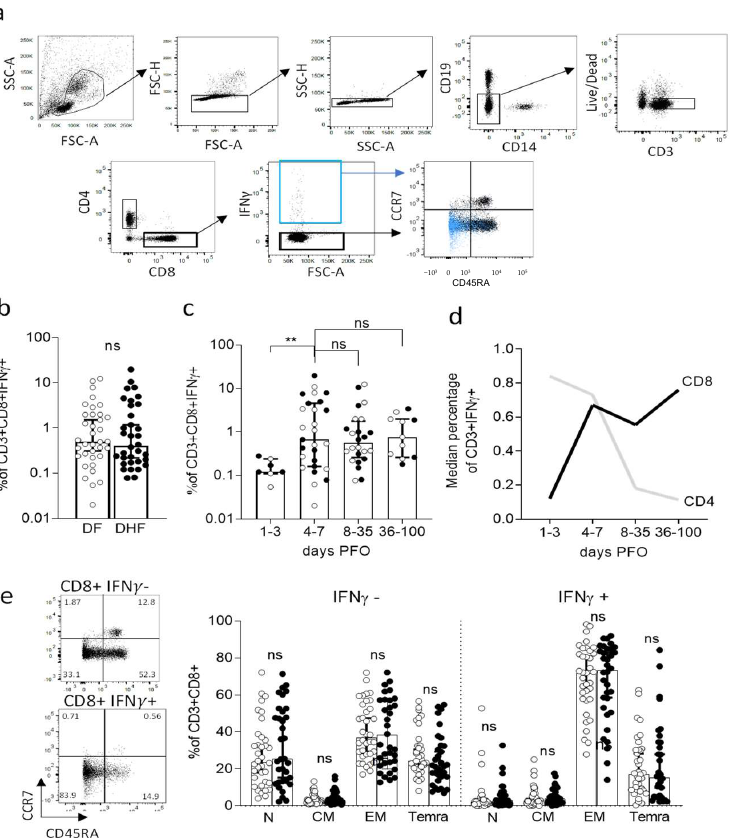
Figure 1. Flow cytometry analysis of DENV-specific CD8+ T cells in DENV hospitalized donors. ( a ) Gating strategy. ( b ) Magnitude of CD3 + CD8+ IFNγ+ T cells responses as a function of disease severity. ( c ) Magnitude of CD3 + CD8+ IFNγ+ T cells responses as a function of days post fever onset (PFO). ( d ) Median percentage of CD3 + CD8+ IFNγ+ T cells compared to previous data generated